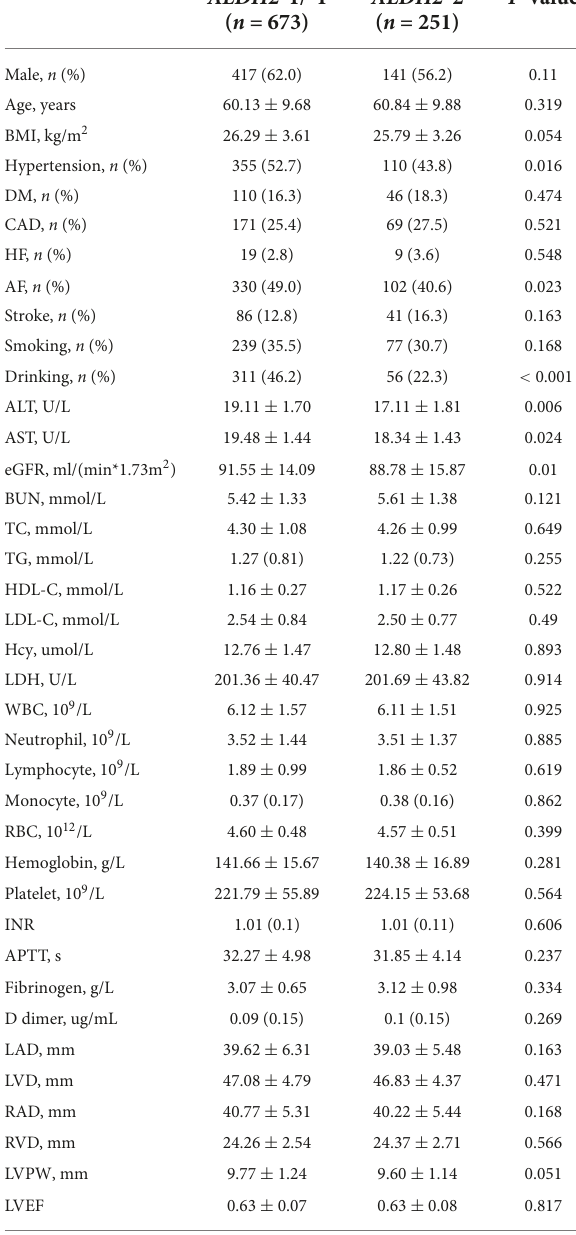
TABLE 1 Baseline characteristics of all subjects between the ALDH2 *1/*1 and ALDH2 *2 group.